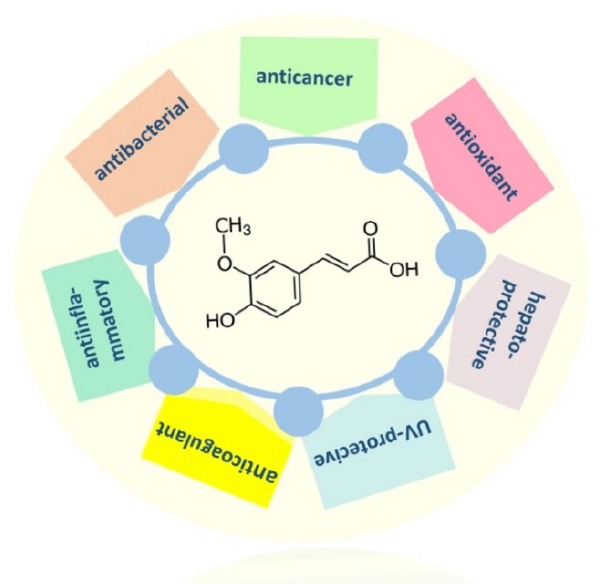
Figure 1. Biological activity of ferulic acid.